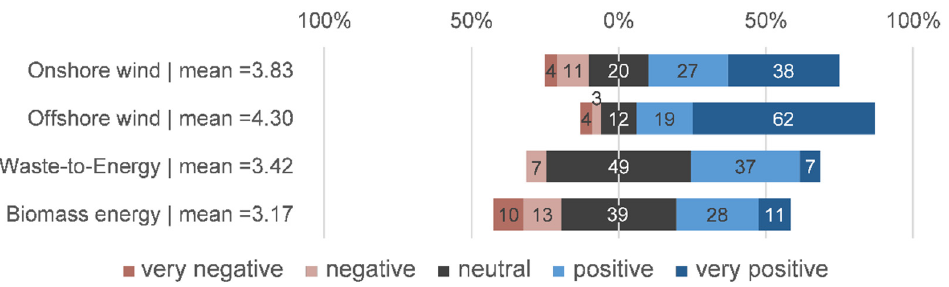
Figure 6. Attitude towards the neighboring technology in % per survey group. Participants answered if they evaluate the neighboring technology as more advantageous or disadvantageous. For the calculation of the mean value, a scale from 1: very negative to 5: very positive was used. To explain the people’s attitudes for energy technologies, Bertsch et al. [68] used or- dinal regression models. Ribeiro [42] used logistic ordinal regression to show the impacts of socio-economic, cultural, demographic, and location aspects on acceptance and NIMBYism. For near-shore wind parks, Johansen [69] found that second homeowners